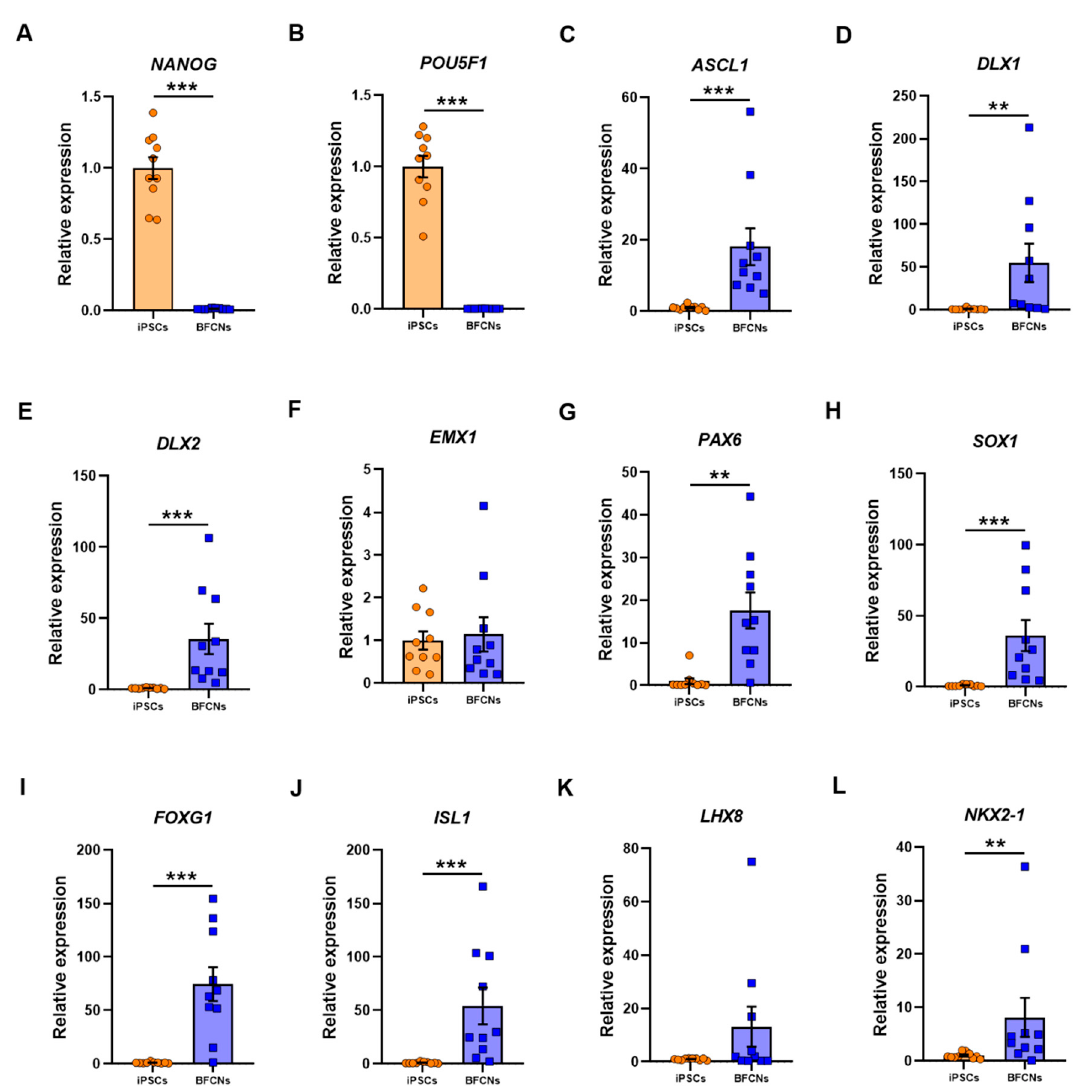
Figure 3. Expression of pluripotency, neuronal progenitors and specific cholinergic progenitor markers in iPSC and BFCN cultures. The iPSC and BFCN samples were analysed by nCounter (Nanostring) and, after normalisation of total amount of RNA molecules to the housekeeper genes, results are shown as fold change of BFCN cultures over iPSCs. Analysis of the pluripotency markers ( A ) NANOG and ( B ) POU5F1 ; the neuronal progenitor markers ( C ) ASCL1 , ( D ) DLX1 , ( E ) DLX2 , ( F ) EMX1 , ( G ) PAX6 ; and ( H ) SOX1 ; and the specific cholinergic progenitor makers ( I ) FOXG1 , ( J ) ISL1 , ( K ) LHX8 and ( L ) NKX2 − 1 . Data are derived from 10 iPSC lines and 10 BFCN differentiated samples from 1 independent differentiation for each line. Individual data are shown. Histogram bars represent mean values and error bars represent S.E.M. Graphs show ** p ≤ 0.01, *** p ≤ 0.001, by Kolmogorov- Smirnov test except in A and B that two-tailed t-test was used for parametric distribution.